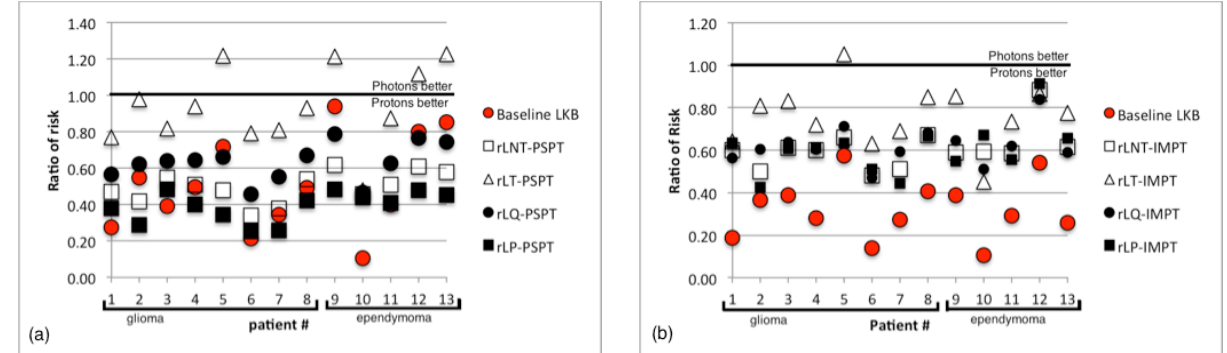
Figure 8. The ratio of risk of necrosis for ( a ) PSPT plans and ( b ) IMPT plans compared to VMAT plans, calculated with baseline Lyman Kutcher Burman (LKB) model, the linear no threshold (LNT), linear threshold (LT), linear quadratic (LQ), and linear plateau (LP)